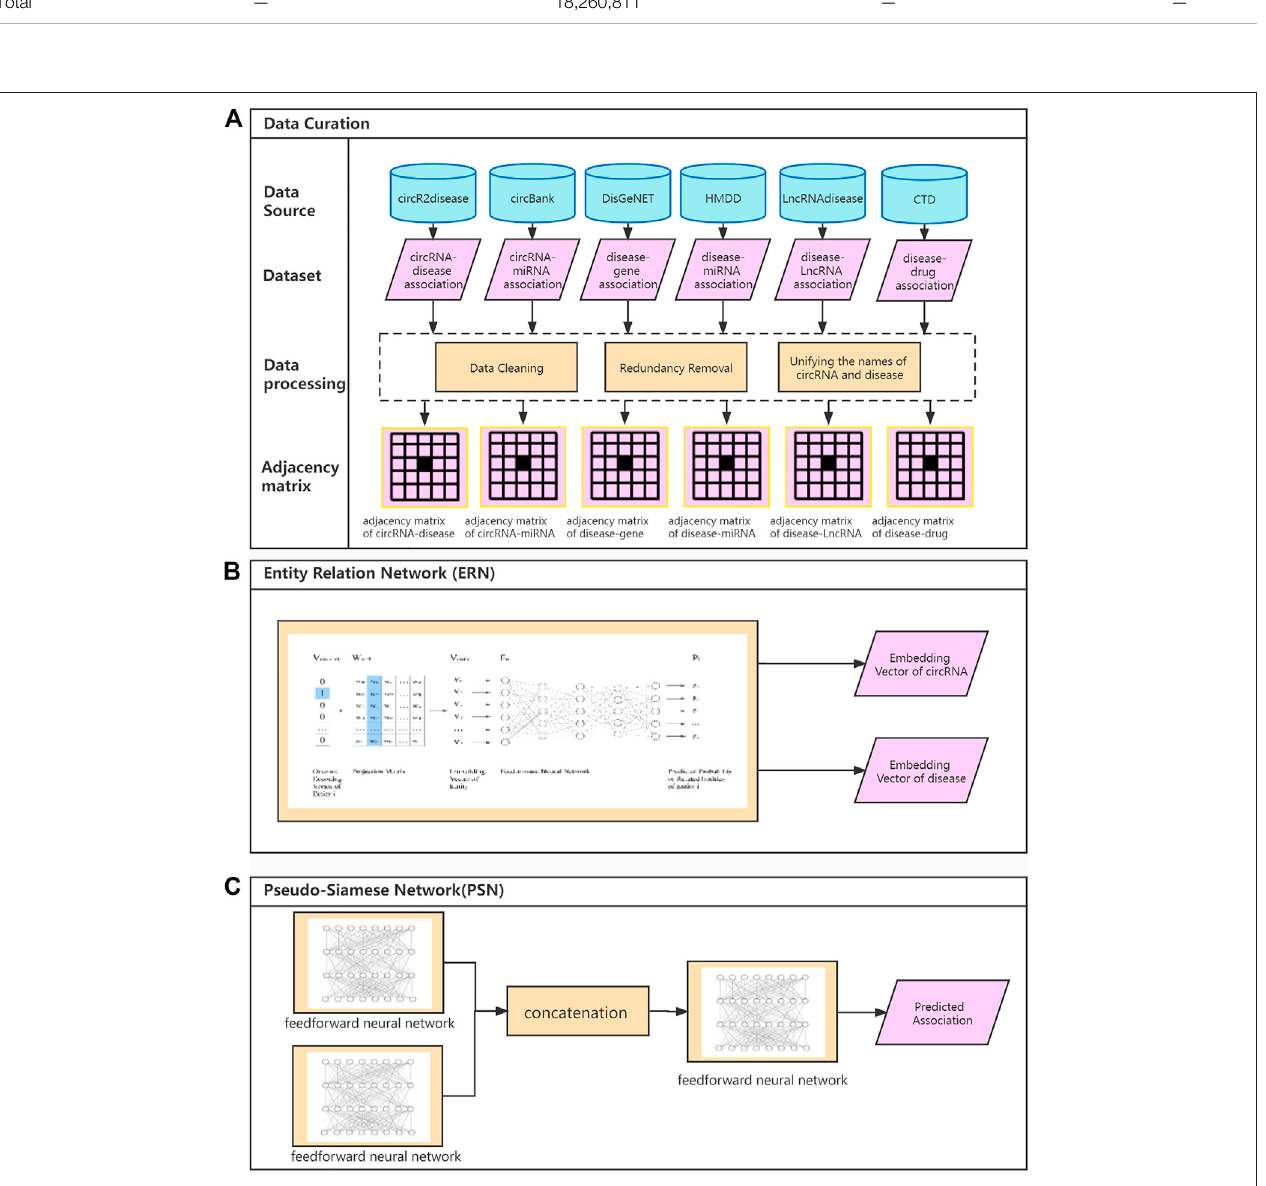
FIGURE 1 | SAAED fl owchart. (A) An outline of fl owchart of data curation. (i) The association information is extracted from data sources. (ii) Data preprocess deal withdatacleaning,redundancyremoval,andunifyingthenamesofcircRNAanddiseasesfromdifferentdatasets.(iii)Theassociationinformation,i.e.,representedbythe adjacency matrix. (B) The Entity Relation Network (ERN) calculates the embedding vectors. (C) The Pseudo-Siamese Network calculates the probability of association with the embedding vector of circRNA and disease.